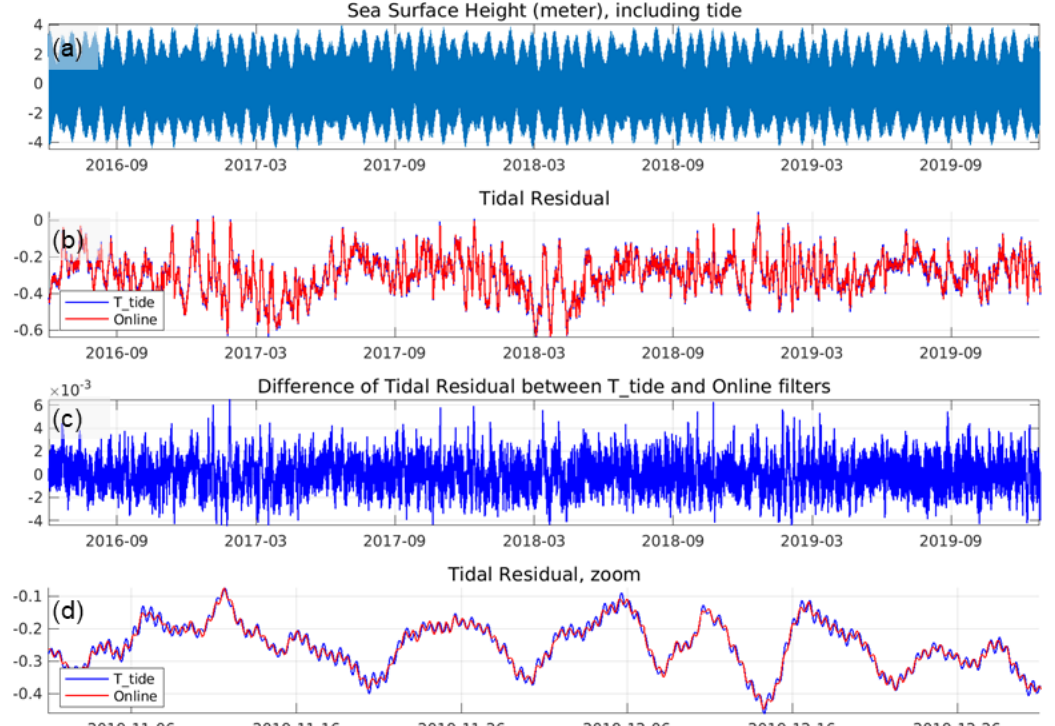
Figure 5. Example illustrating the performance of the online harmonic analysis compared to the T_tide offline filter for a location in Ungava Bay (location shown with a star in Fig. 6). Unfiltered sea surface height (SSH) variations (in meters) are shown in panel (a) . The residual SSH variability following removal of the tidal signal using the T_tide package (blue line) and the online harmonic analysis (red line) is shown in panel (b) . The difference between the two residuals is shown in panel (c) . Panel (d) provides a subsample (zoom) of the results from panel (b) over a roughly 2-month